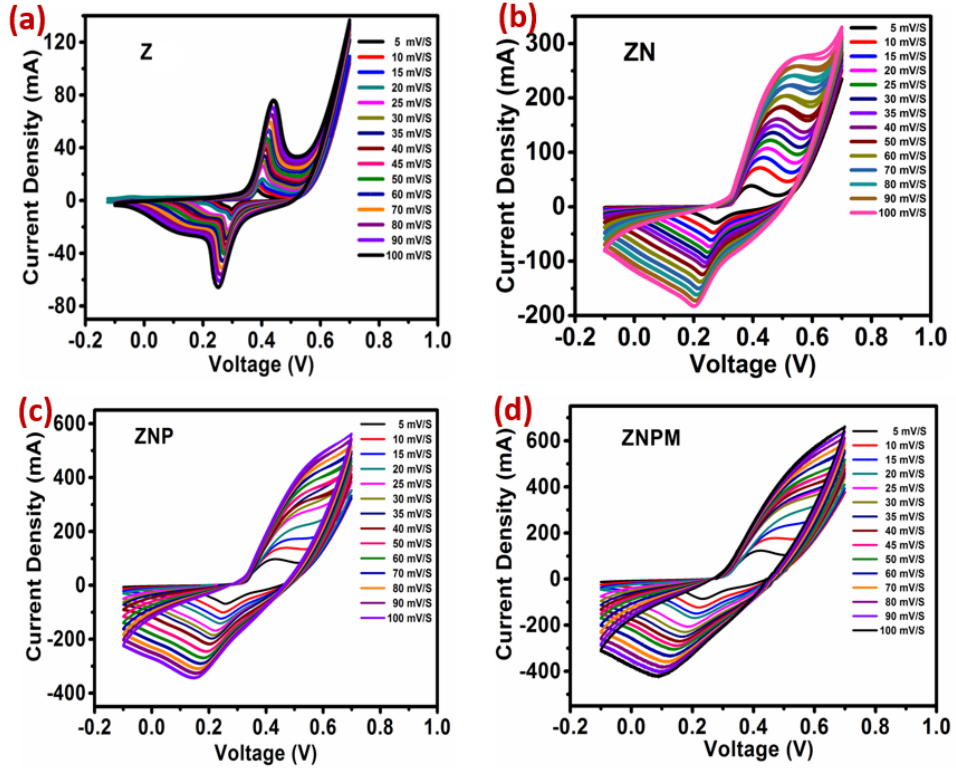
Figure 5. CV of ( a ) Z ( b ) ZN ( c ) ZNP and ( d ) ZNPM at different scan rates in a 2 M KOH